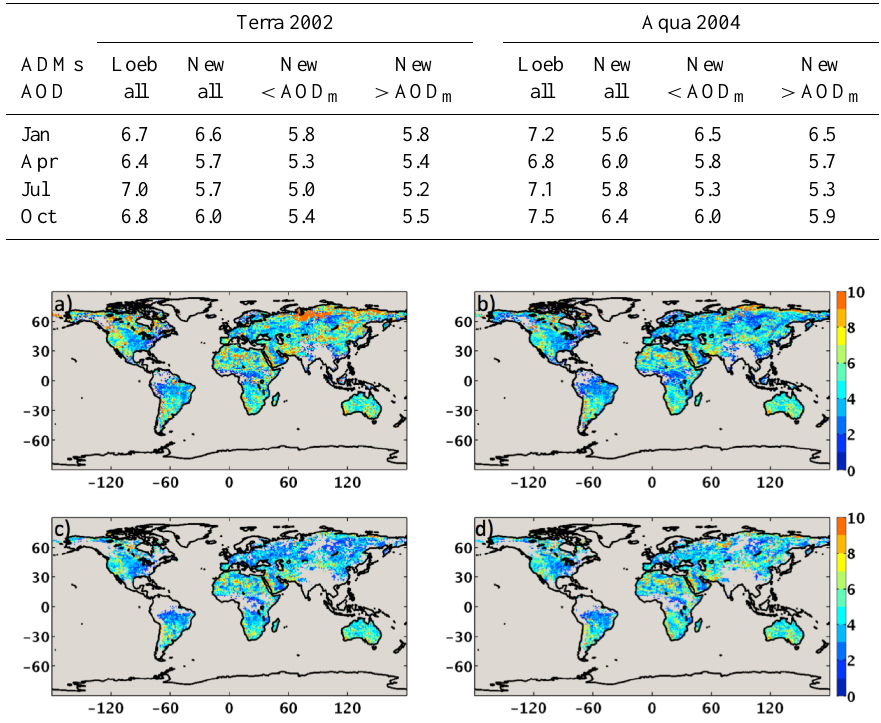
Figure 7. The rms error between normalized measured radiances and normalized ADM-predicted radiances for clear-sky land, (a) using ADMs from Loeb et al. (2005), (b) using the new ADMs, (c) using the new ADMs only for footprints with AODs less than the median AOD, and (d) using the new ADMs only for footprints with AODs greater than the median AOD. in boreal summer and